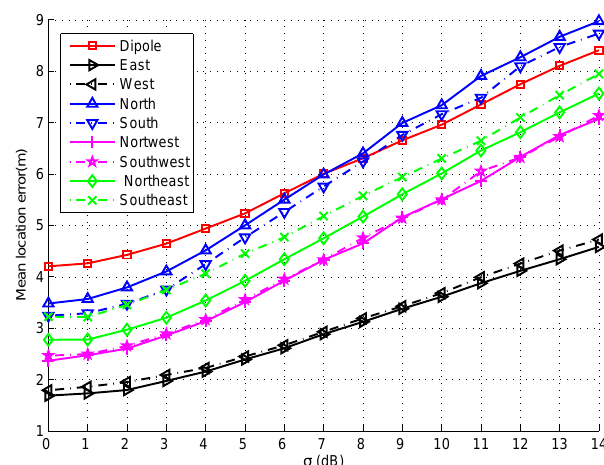
Figure 6: Mean location error vs. noise standard deviation (cid:27) ( 60 ◦ beam directional